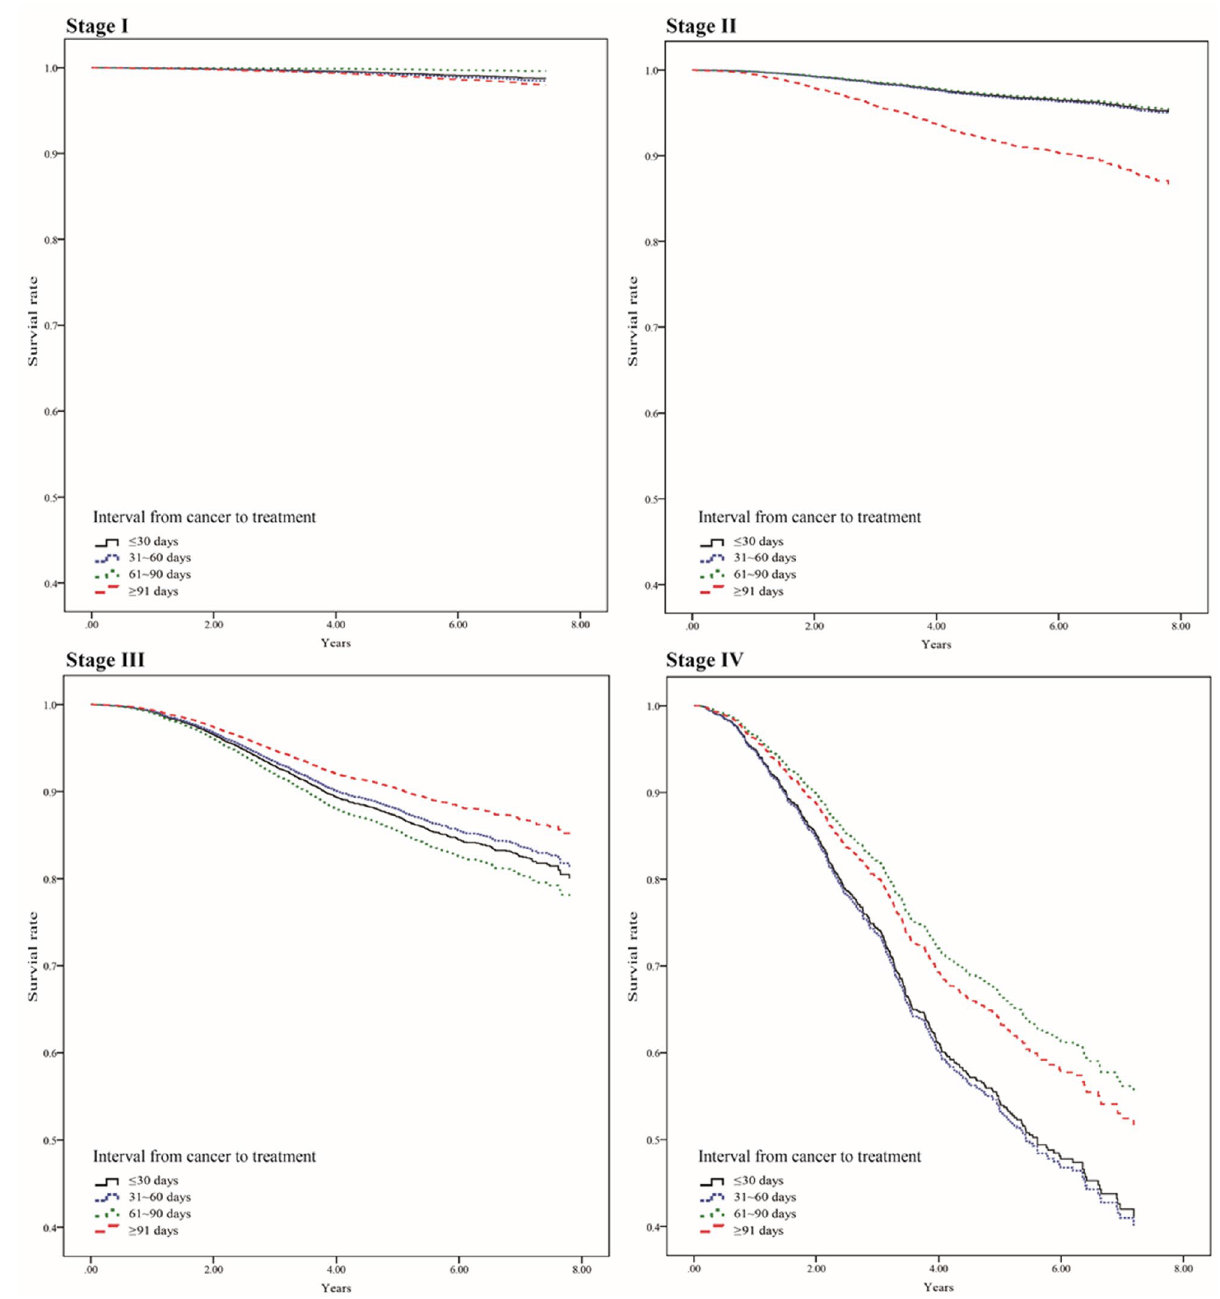
Figure 2. Adjusted survival curves of patients with different breast cancer stages and DFTIs. The related variables (age, marital status, education level, monthly salary, level of urbanization, CCI score, tumor size, number of involved lymph nodes, hormone receptor status, HER2 status, treatment type, hospital level, and hospital ownership) were